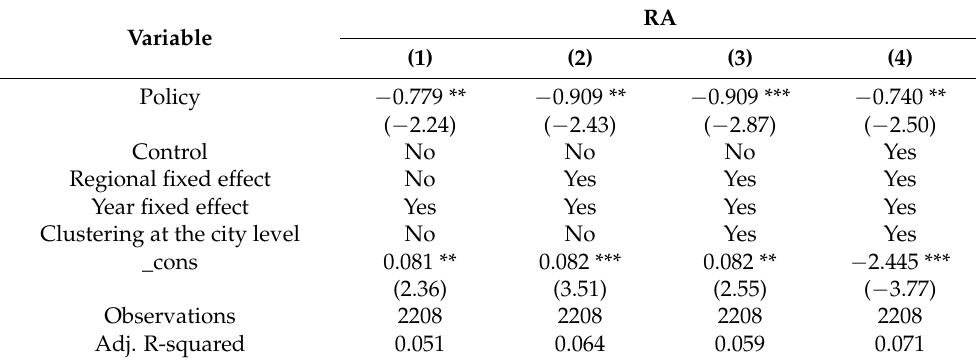
Table 14. Effects of low-carbon city construction (LCC) on resource allocation efficiency.